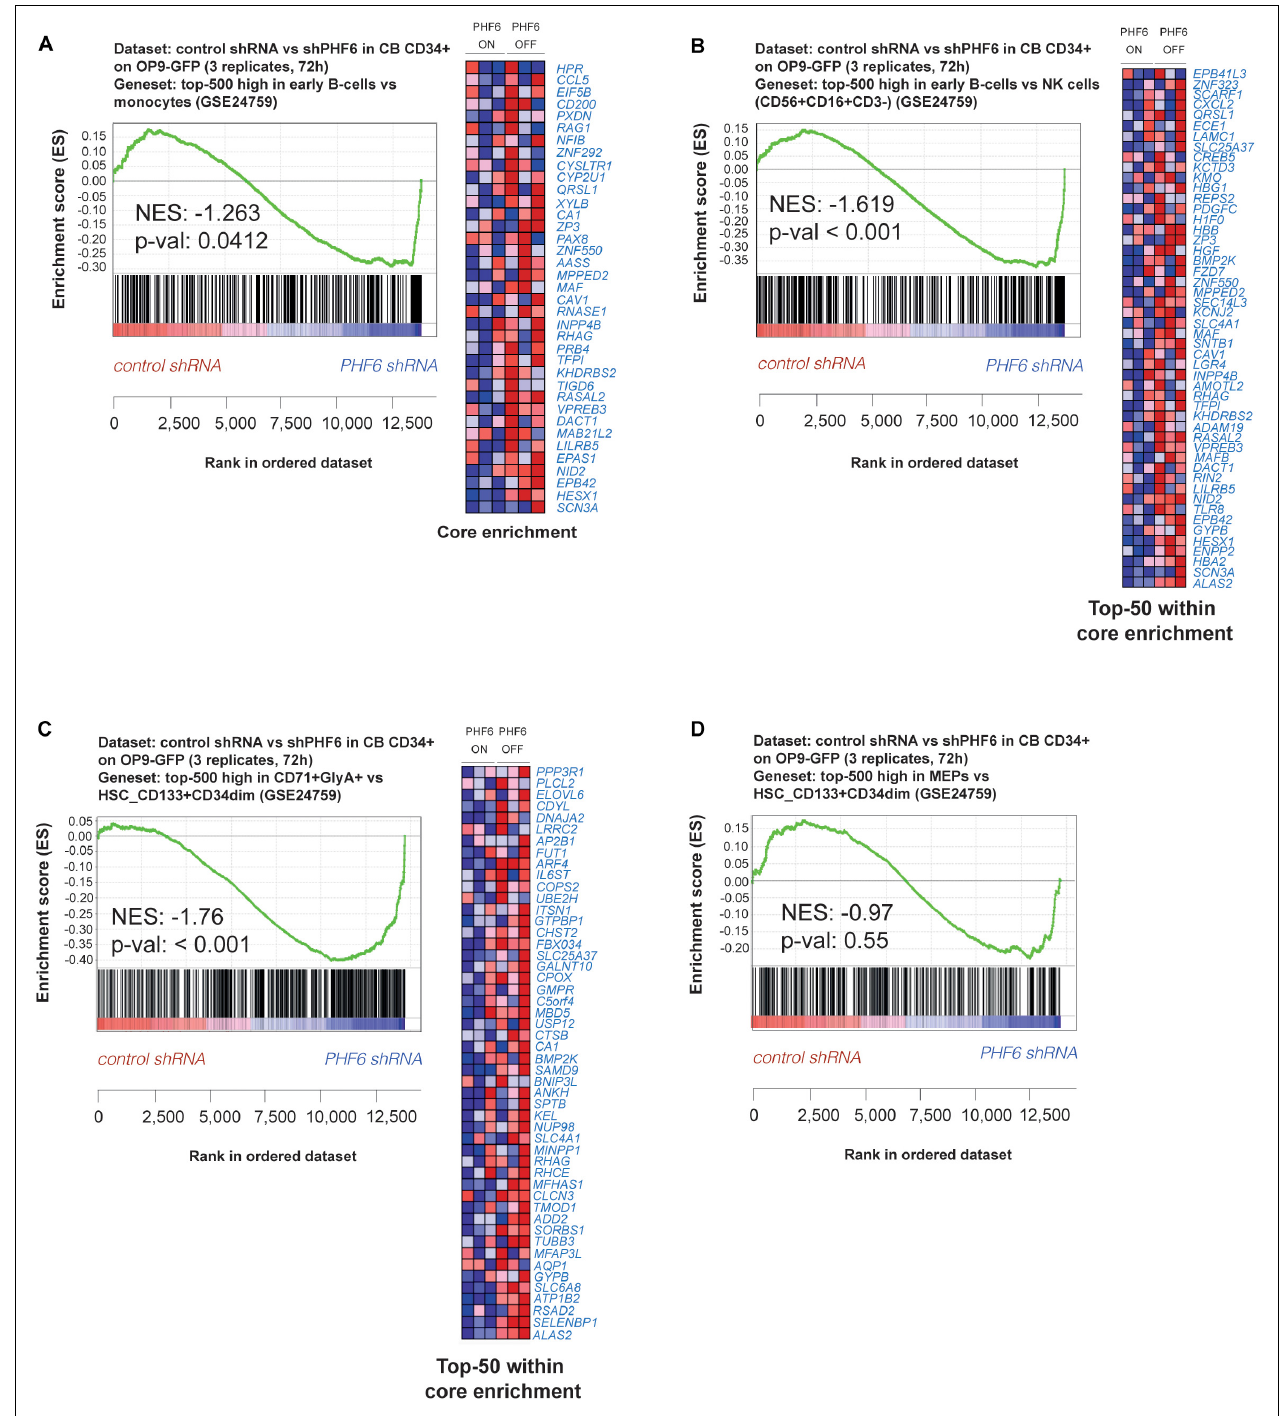
FIGURE 3 | PHF6 controls the expression of hematopoietic lineage genes. (A,B) Gene Set Enrichment Analysis shows that an early B cell gene signature is significantly enriched at expense of (A) a myeloid gene signature (GSE24759) and (B) NK cell (CD56 + CD16 + CD3 − ) gene signature (GSE24759) in short-term cultures of CD34 + progenitors on an OP9-GFP stromal feeder layer with stable PHF6 knockdown (GSE85373). (C,D) Gene Set Enrichment Analysis shows that an erythrocyte gene signature (C) but not a MEP gene signature (D) is significantly enriched at expense of a HSCs gene signature (GSE24759) in short-term cultures of CD34 + progenitors on an OP9-GFP stromal feeder layer with stable PHF6 knockdown.